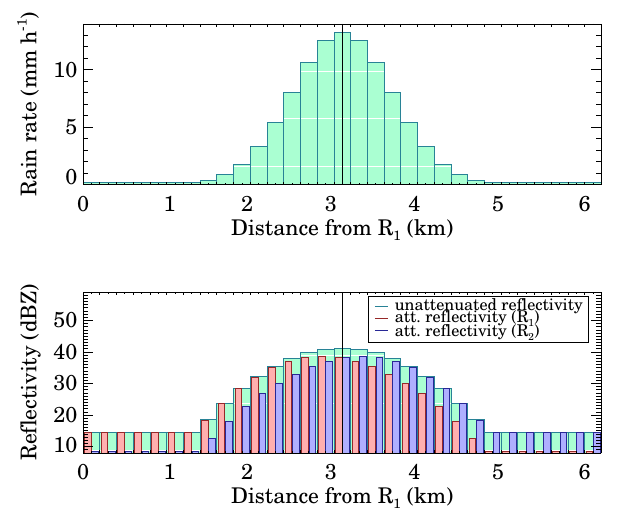
Figure 3. In analogy with Fig. 2, rain rate and simulated reflectivity fields for a precipitation pattern with a maximum intensity above R 3 (maximum rain rate is 13.3mmh − 1